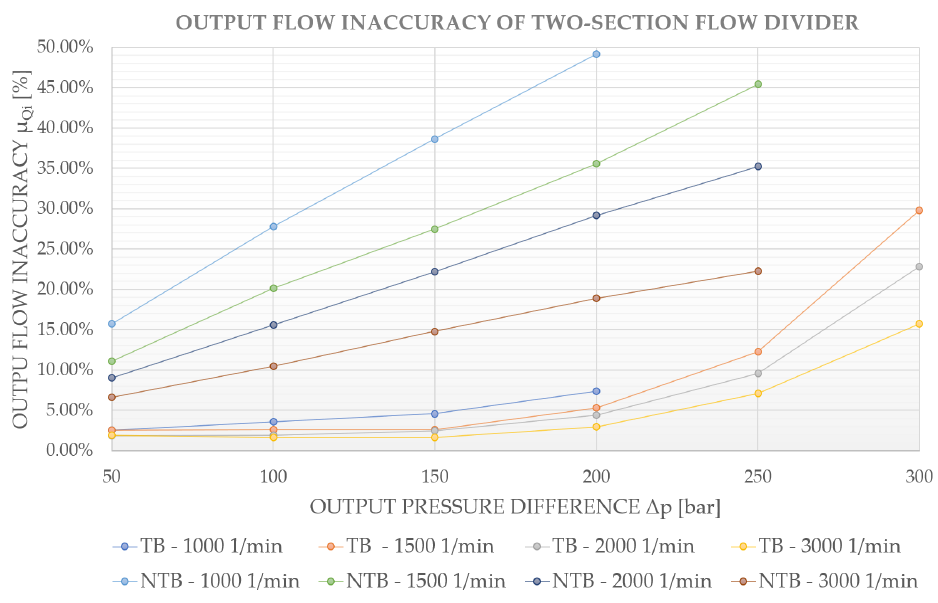
Figure 7. Flow dividing